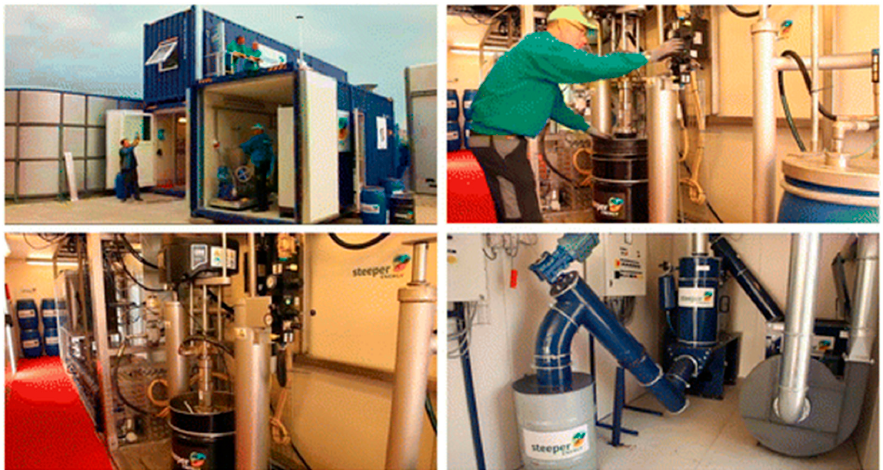
Figure 6. Operations of the Hydrofaction™ process at the pilot plant at Aalborg University, operated by Steeper Energy. Reproduced from [13], with permission from Springer, © Springer-Verlag 2017.